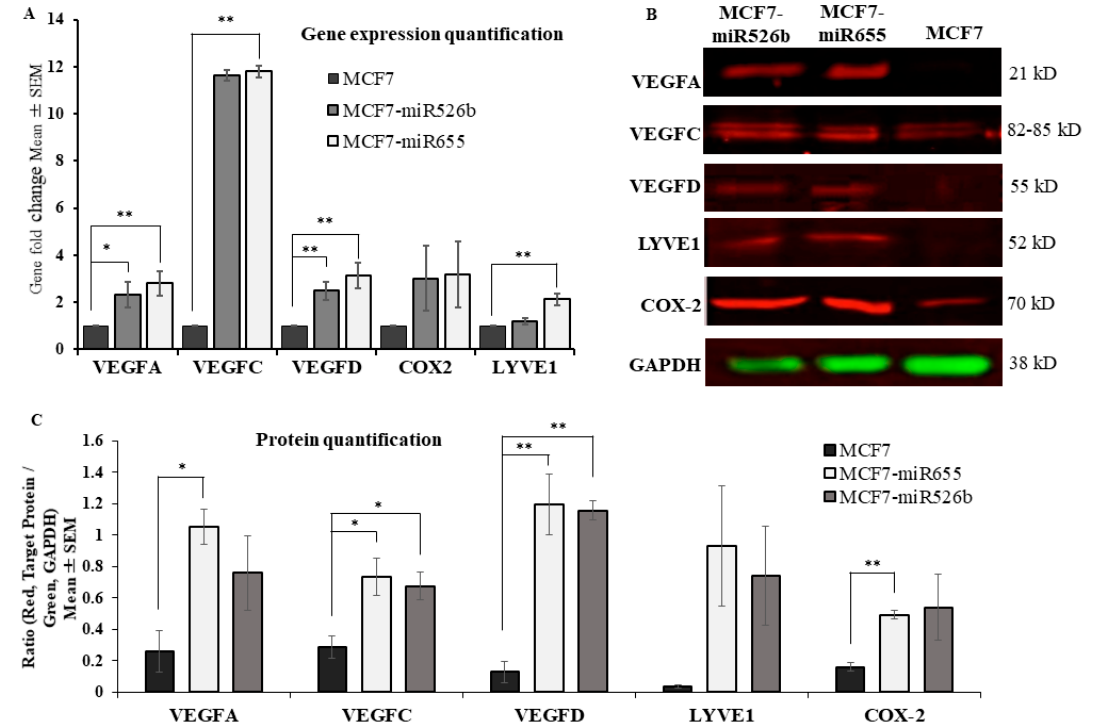
Figure 1. Overexpression of miR526b and miR655 in MCF7 cell line results in upregulation of angiogenesis and lymphangiogenesis markers. ( A ) Quantitative real time polymerase chain reaction (qRT-PCR) shows angiogenic and lymphangiogenic markers at the mRNA level with significant positive fold changes in the miRNA overexpressed cell lines, MCF7-miR526b and MCF7-miR655, compared with the MCF7 cell line. ( B ) The Western blot analysis shows a larger presence of angiogenesis and lymphangiogenesis markers at the protein level in the MCF7-miR655 and MCF7-miR526b cell lines compared with the MCF7 cell line. Green: control marker Glyceraldehyde 3-phosphate dehydrogenase (GAPDH), red: target proteins, either VEGFA or VEGFC or VEGFD or LYVE1 or COX-2. ( C ) Quantitative analysis of Western blot shows increased levels of angiogenesis and lymphangiogenesis markers. RT-PCR and Western blot quantitative data are presented as the mean ± SEM of triplicate replicates; * p < 0.05, ** p < 0.01. LYVE-1—lymphatic vessel endothelial hyaluronan receptor-1; VEGF—vascular endothelial growth factors; COX-2—cyclo-oxygenase 2. Expression of receptors VEGFR1 and EP4 was found to be significantly upregulated in both the MCF7-miR526b and MCF7-miR655 cell lines (Figure 2A). VEGFR2 was found to be marginally upregulated in MCF7-miR526b and MCF7-miR655 cell lines; however, this was not statistically significant (Figure 2A).